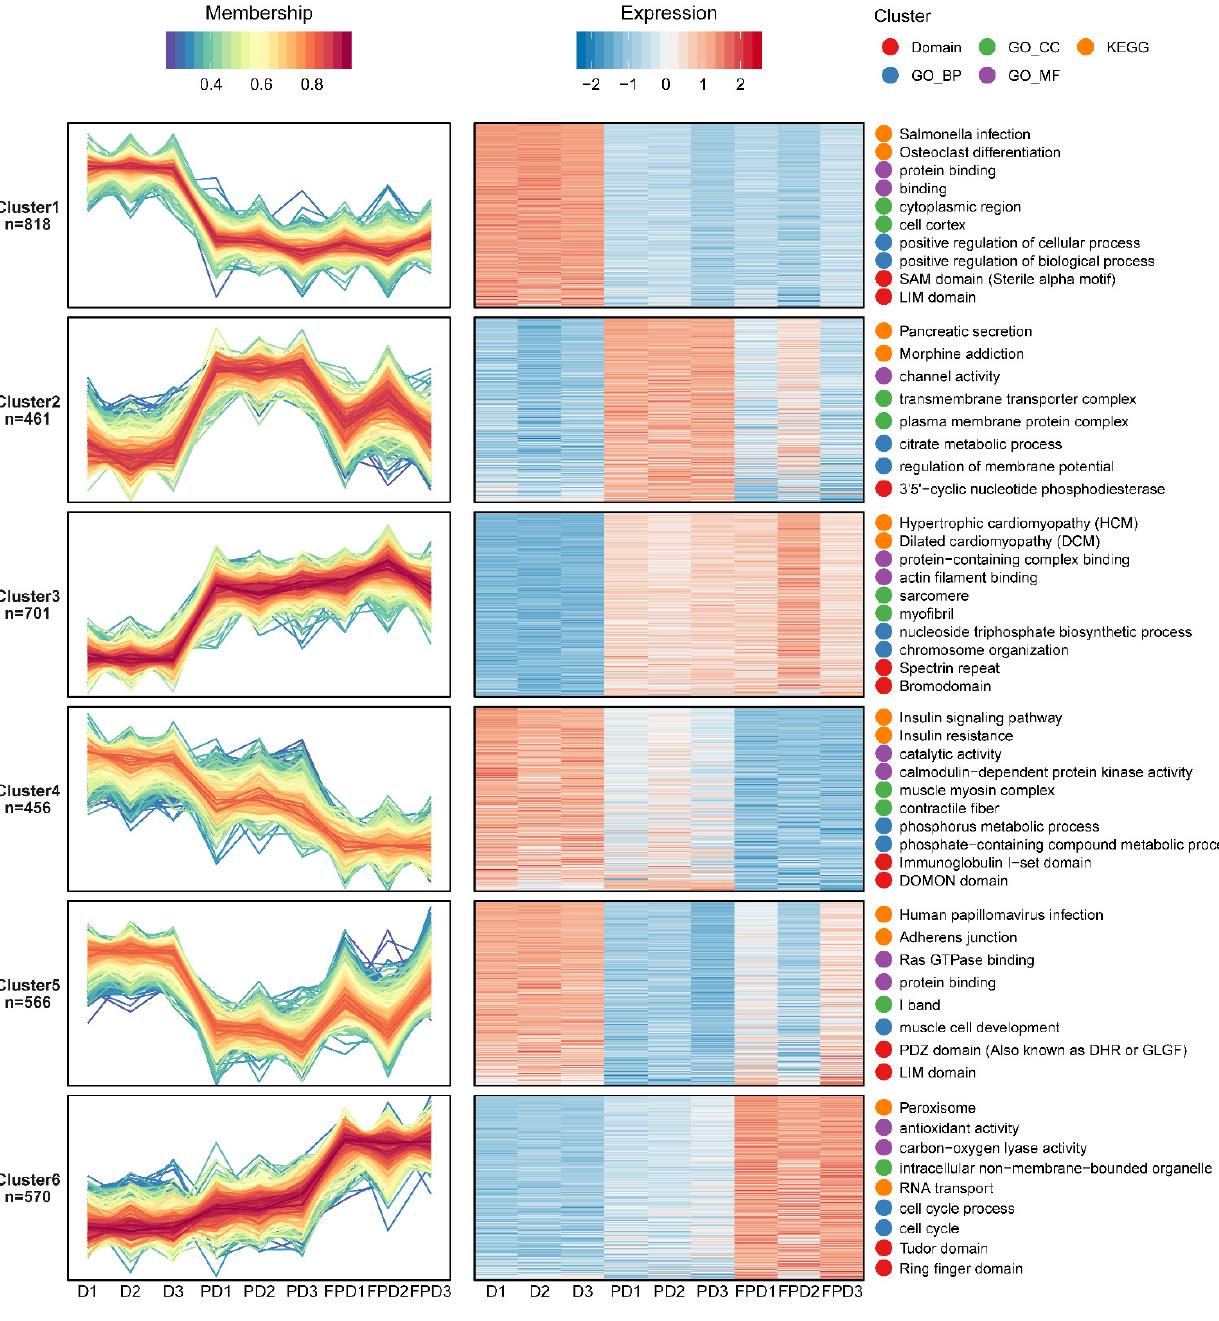
Figure 4. Functional clustering of differentially expressed phosphoproteins. A fuzzy clustering algorithm was used to identify coregulated phosphoprotein modules. The two most highly enriched GO/KEGG/domain entries are displayed on the right side of the corresponding cluster graph.